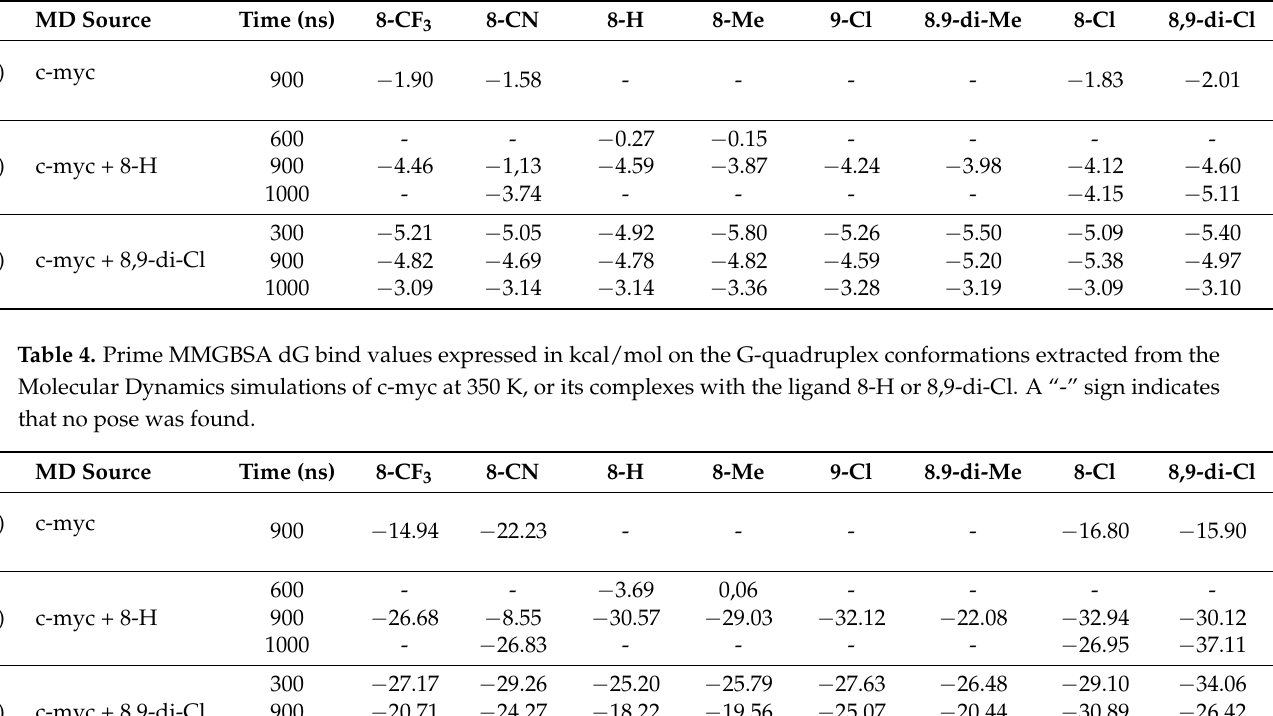
Table 3. Glide XP docking G-Score values expressed in kcal/mol obtained on the Q-quadruplex conformations extracted from the Molecular Dynamics simulations of c-myc at 350 K, or its complexes with the ligand 8-H or 8,9-di-Cl. A “-” sign indicates that no pose was found.